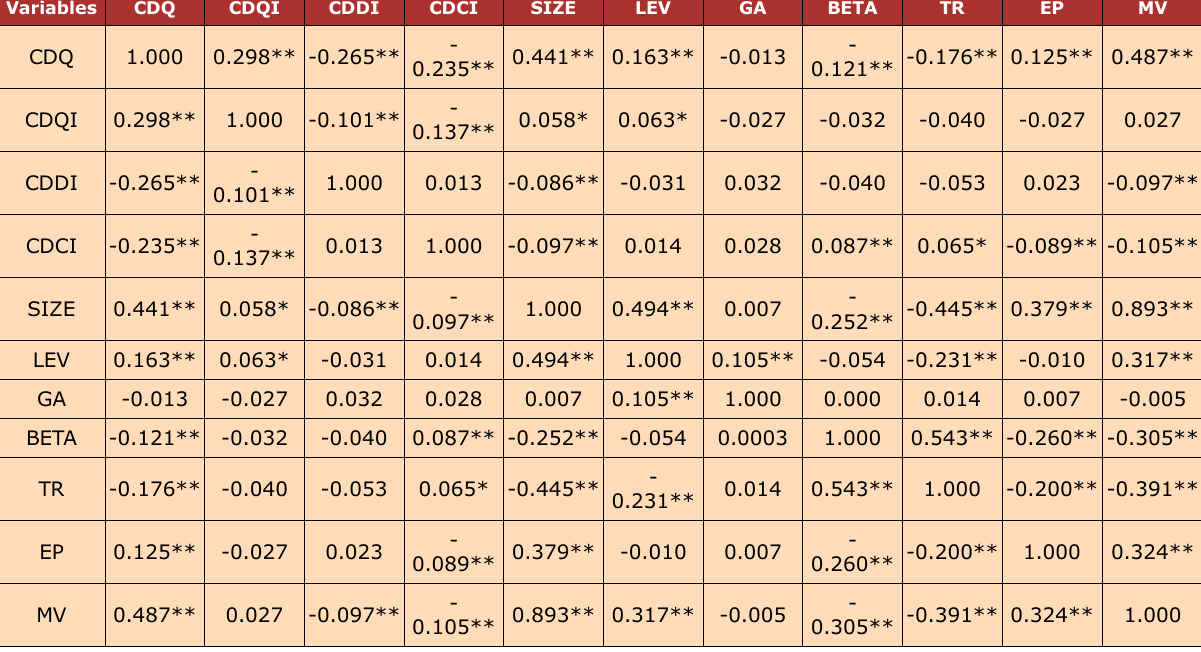
Table 3. Correlation analysis on